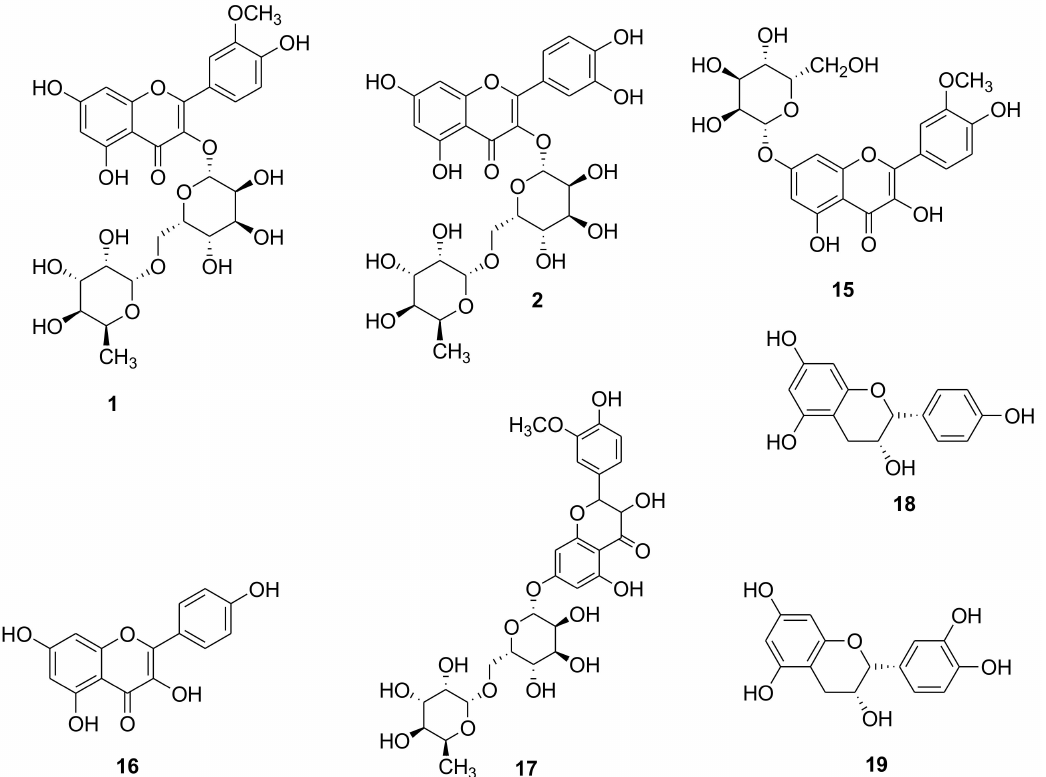
Figure 2. The isolated compounds structures from Ravenala madagascariensis